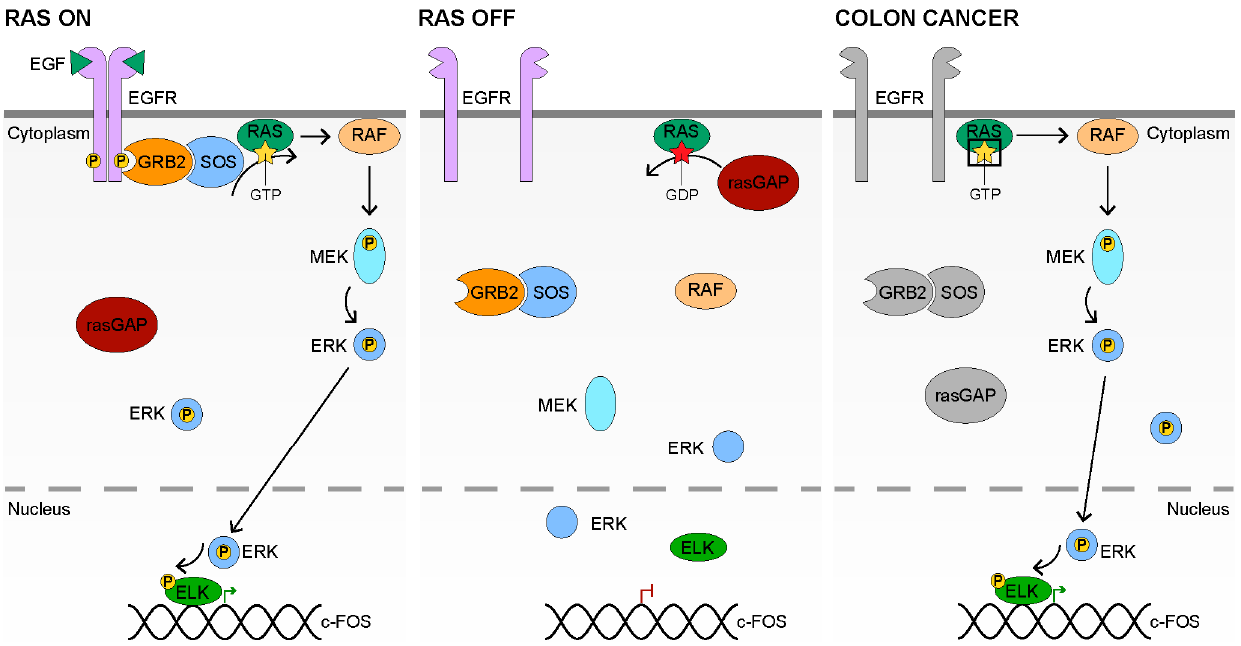
Figure 2. The RAS-MAPK Signaling Pathway. In the RAS ON state ( left ), EGF binds to EGFR with 2:2 stoichiometry at the plasma membrane. EGF binding results in dimerization of the receptors, and their autophosphorylation. GRB2 binds to the phosphorylated tyrosine on EGFR via its SH2 domain, and subsequently recruits the rasGEF, SOS. SOS catalyzes the exchange of GDP for GTP on RAS, activating it. Activated RAS then activates RAF, which phosphorylates MEK, which, in turn, phosphorylates ERK. Phosphorylated ERK travels to the nucleus, though some remains in the cytoplasm, resulting in the phosphorylation of cytoplasmic and nuclear targets. ERK phosphorylates the transcription factor ELK, which allows it to form a ternary complex with serum response factor (SRF) at serum response elements (SREs). The complex then drives the expression of growth factor response genes, such as FOS , a component of the AP-1 transcription factor. In the RAS OFF state ( center ), no EGF or EGF-like ligand is present and EGFR remains unbound, its dimerization inhibited by its conformation. GTP bound to RAS is hydrolyzed to GDP by rasGAP, inactivating it. RAS which is bound to GDP, remains so. GRB2 and SOS remain unbound to EGFR, and RAF is inactive. MEK and ERK remain unphosphorylated, with some ERK remaining in the nucleus. ELK is unphosphorylated and is unable to form a ternary complex with SRF at the SRE. In Colon Cancer ( right ), K-RAS is mutated, at codon 12, which renders it refractory to GTP–GDP exchange by rasGAP, and rasGAP is, therefore, in grey. The actions of the upstream components EGFR, GRB2, and SOS are also in grey as their purpose, promoting the GTP bound state of RAS, has been achieved. RAF–MEK–ERK is active, inducing the activity of ELK and